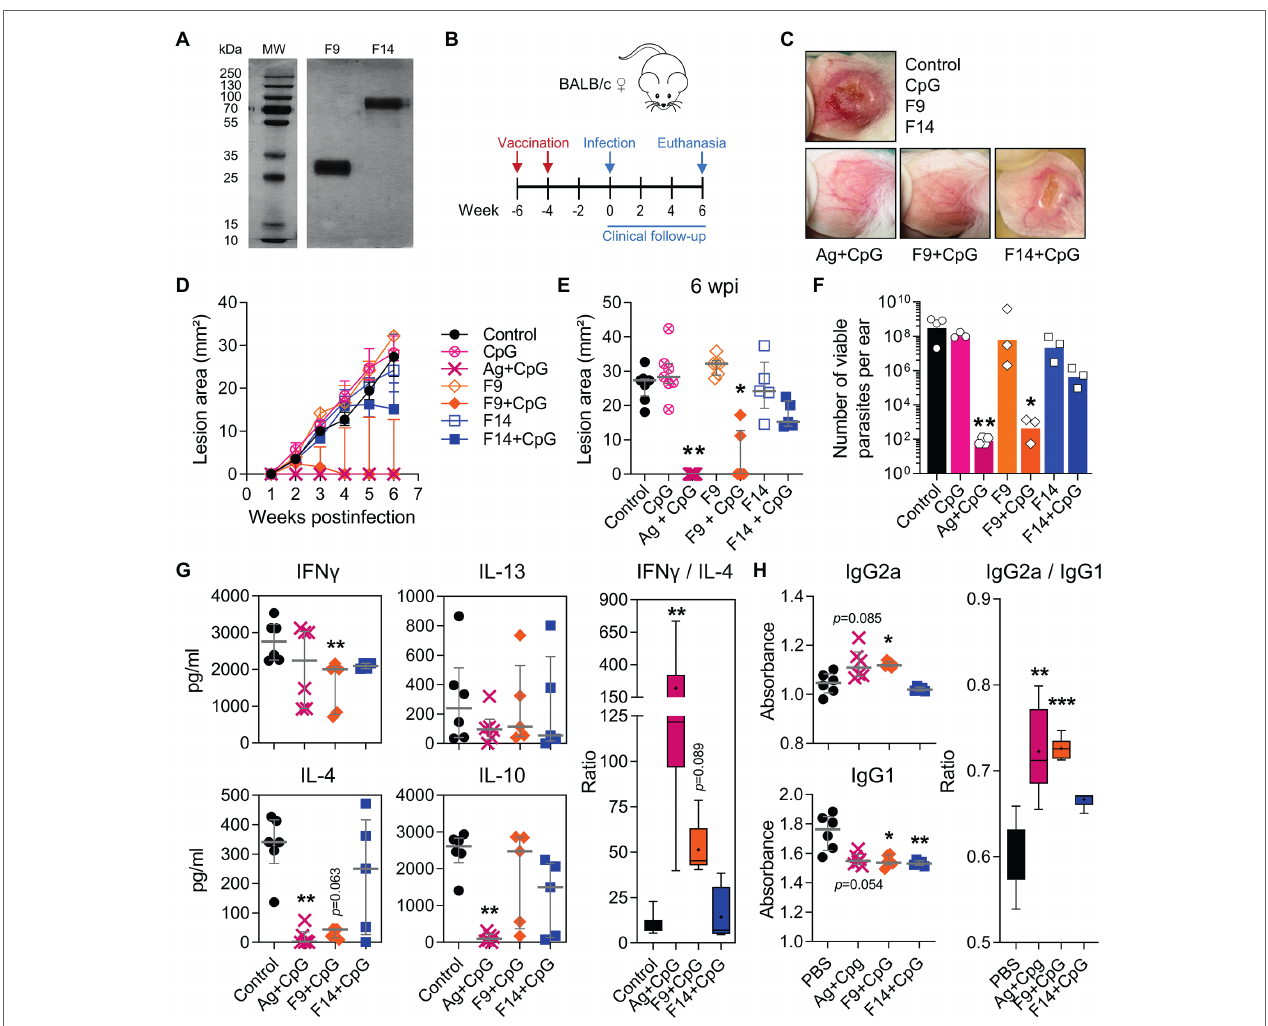
FIGURE 8 | A 28–30 kDa protein fraction of the L(V)p proteome that protects against an infective challenge. In an independent experiment but following the same strategy presented in Supplementary Figure S15 , the fractions F9 and F14 from the L(V)p promastigote proteome were obtained and run in SDS/PAGE gels. The photograph of a silver-stained gel presented in (A) confirmed that yield, purity, and integrity of the fractions were appropriated for in vivo testing. Mice were then vaccinated sc on the back with 6 μ g of the protein fraction in combination with 3.5 μ g CpG and boosted 2 weeks later with the same preparation to be infected with L(V)p 4 weeks after the boost (B) . PBS- or Ag + CpG-injected mice were used as negative and positive controls, respectively. Representative photographs illustrating the appearance of the infected ears in the different experimental groups at the 6th week postinfection are shown (C) . Lesion size was registered weekly and graphed as the kinetics of lesion growth (D) or the size of the lesion in individual mice at the 6th week postinfection (E) . Animals were sacrificed at the 6th week postinfection, and the ears used to quantify the numbers of viable parasites by limiting dilution assay (F) . Cell suspensions from dLN were stimulated with L(V)p Ag and the amounts of the indicated cytokine determined by ELISA (G) . The IFN γ /IL-4 ratios were calculated and graphed ( G , right ). Serum samples were also obtained and used to quantify the circulating levels of L(V)p -specific IgG1 and IgG2a antibodies (H) . IgG2a/IgG1 ratios were also calculated and graphed ( H , right ). Data are shown as the median ± interquartile range ( D,E,G,H ; n = 4–6 mice per group), or the geometric mean ± 95%CI ( F ; n = 3 pools from 5 to 6 mice per group). Ratios presented in (G,H) are graphed as “box and whiskers” plots. MW: molecular weight. wpi: weeks postinfection. * p < 0.05, ** p < 0.01, and *** p < 0.001 (Kruskal–Wallis test with Dunn’s multiple comparison post-hoc